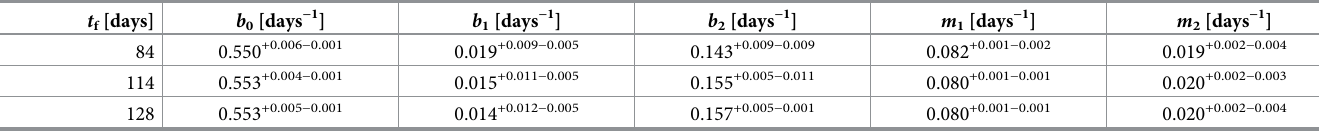
Table 1. Fit parameters obtained for β ( t ) for three choices of the final day t f used in the fit, namely for day 84 (June 1 st ), 114 (July 1 st ), and 128 (July 15 th ), with t = 0 being April 9 th . Errors are quoted with the superscript and subscript for the upper and lower bounds respectively, obtained via a Markov chain Monte Carlo as explained in the